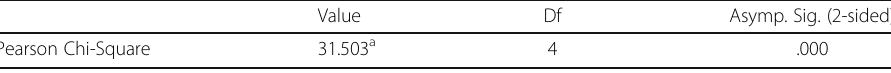
Table 3 Chi-Square analysis of the teachers ’ perceptions towards explicit grammar instruction and corrective feedback Value Df Asymp. Sig. (2-sided) Pearson Chi-Square 31.503 a 4 .000